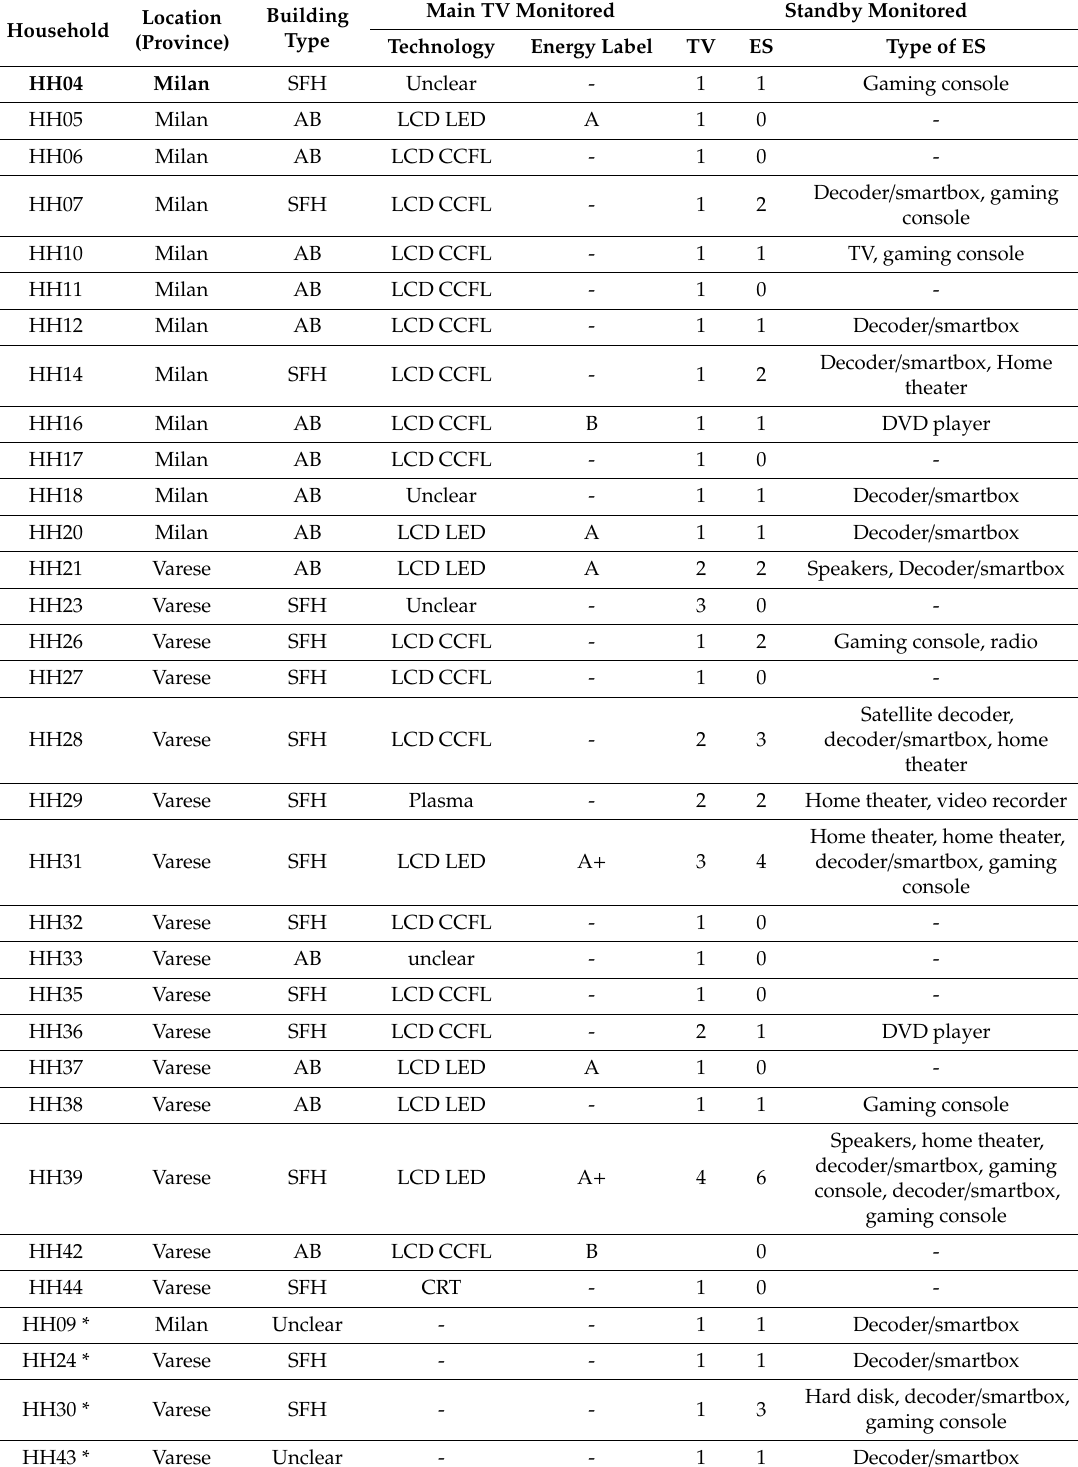
Table 2. Main characteristics of the monitored households (SFH: single-family house, AB: apartment block, TV: television, ES: entertainment system, LCD: liquid crystal display, LED: light-emitting diode, CCFL: cold cathode fluorescent lamp, DVD: digital versatile disc, CRT: cathode ray